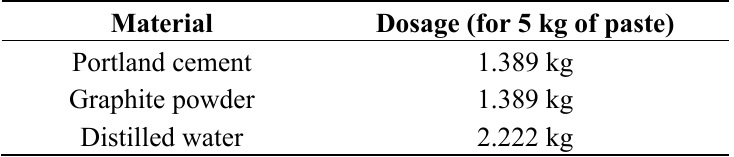
Table 2. Dosage of graphite-cement paste for 5 kg of